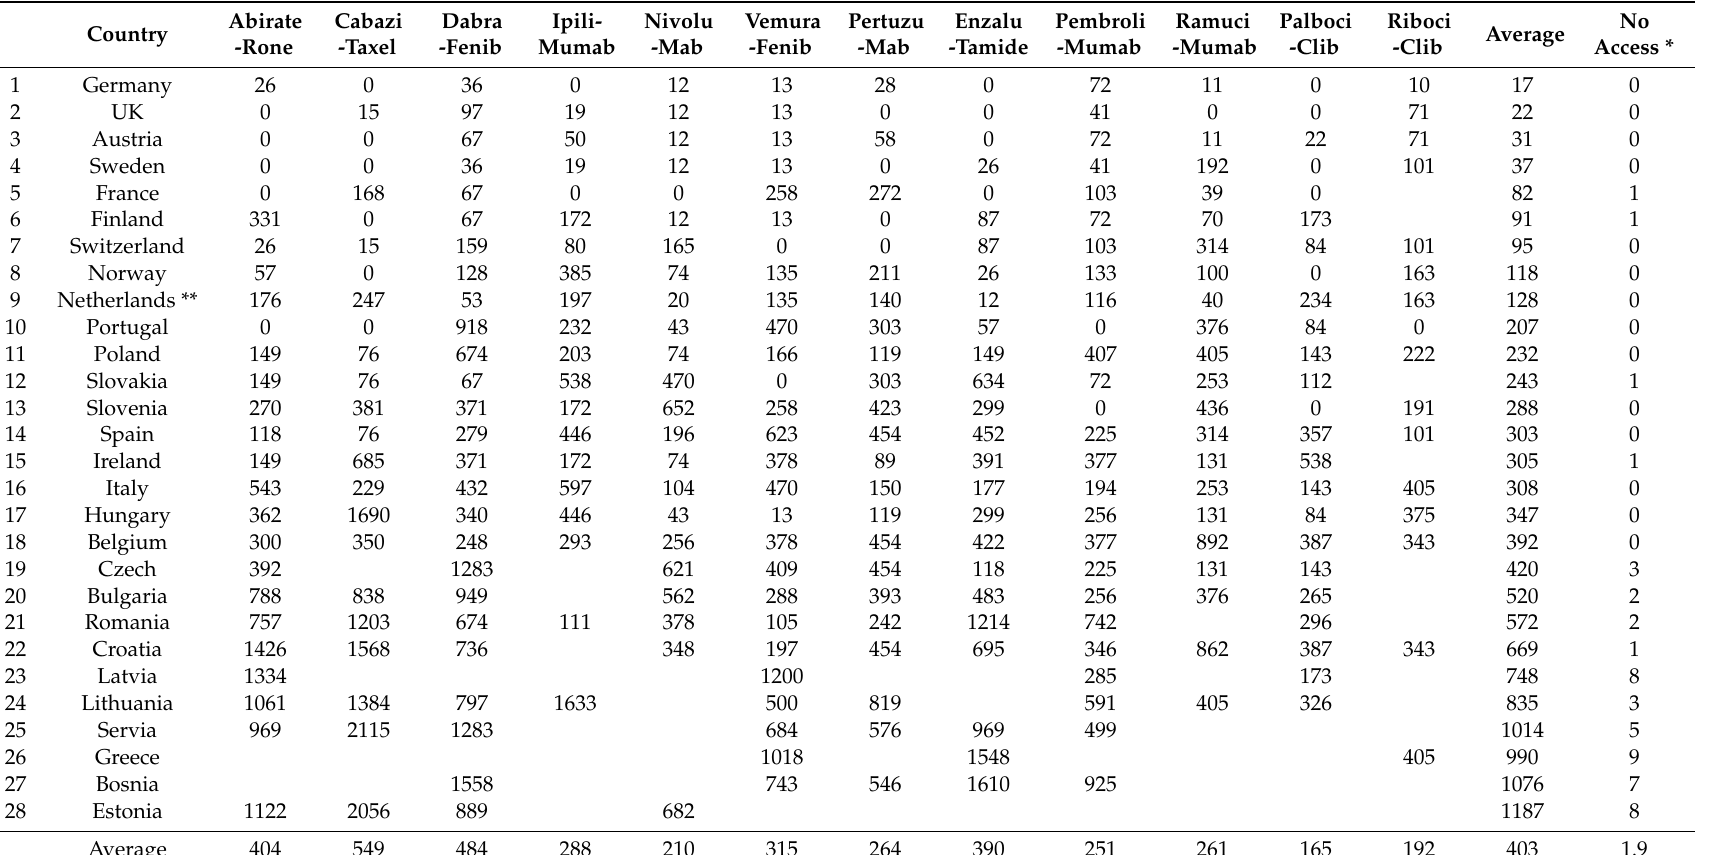
Table A2. Time from EMA registration until first uptake per drug per country (in